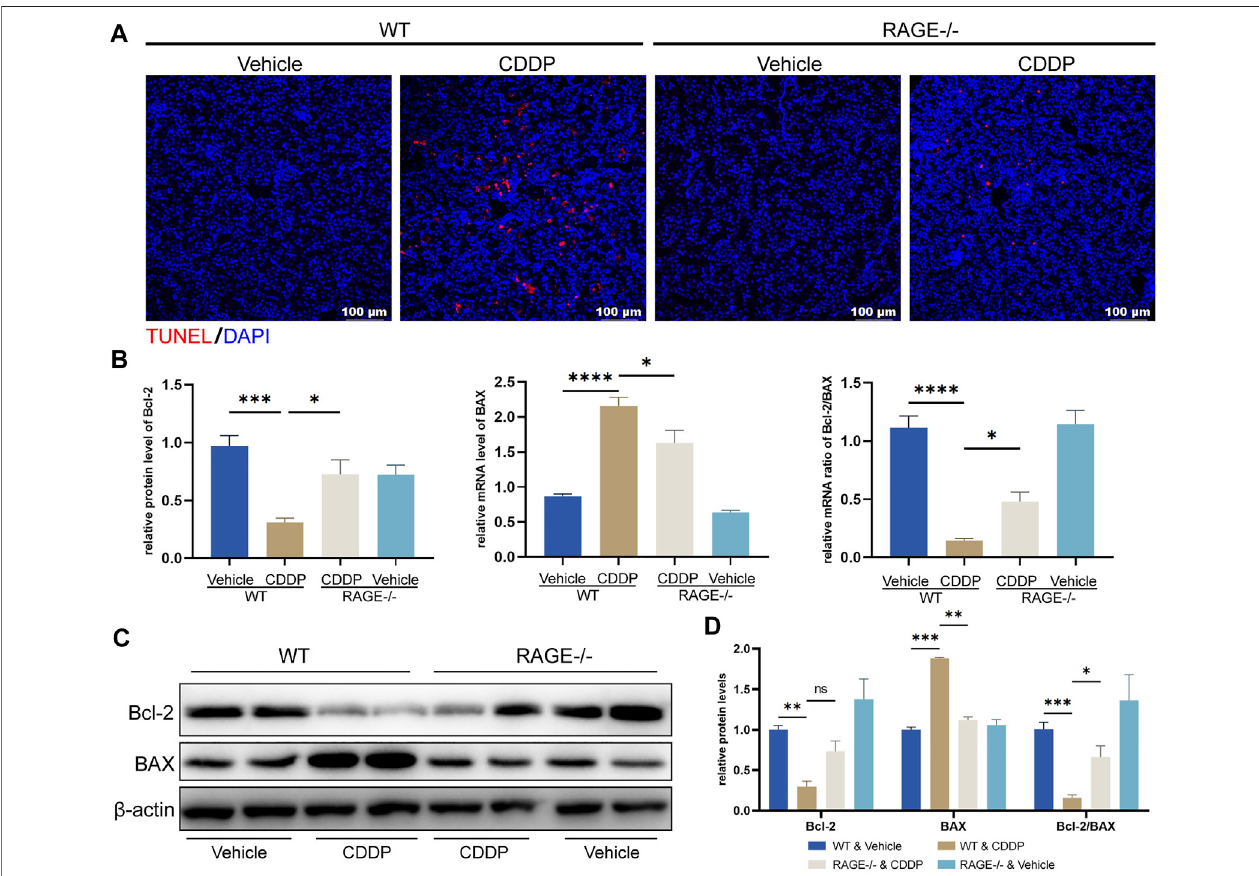
FIGURE 2 | RAGE knockout reduced cisplatin-induced apoptosis of nephrocytes. (A) TUNEL staining of paraf fi n sections of mouse kidneys. (B) The mRNA levels of Bcl-2 and BAX were detected by qPCR, and the ratio of Bcl-2/BAX was calculated. One-way ANOVA was used to compare means between groups. (C) The protein levels of Bcl-2 and BAX were detected by western blot and then semi-quanti fi ed in a histogram with Two-way ANOVA (D) . Data are expressed as mean ± SEM. Scale bar: 100 μ m. * p < 0.05, ** p < 0.01, *** p < 001, **** p < 0.0001. ns, not signi fi